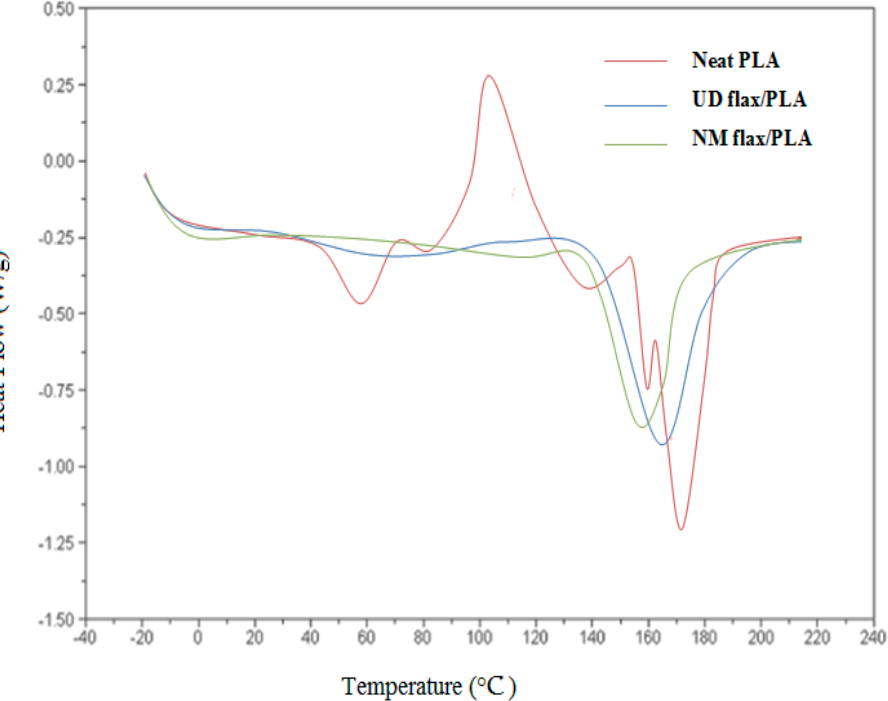
Figure 7. DSC curves of second heating cycle as a function of temperature of neat PLA and flax/PLA biocomposites.